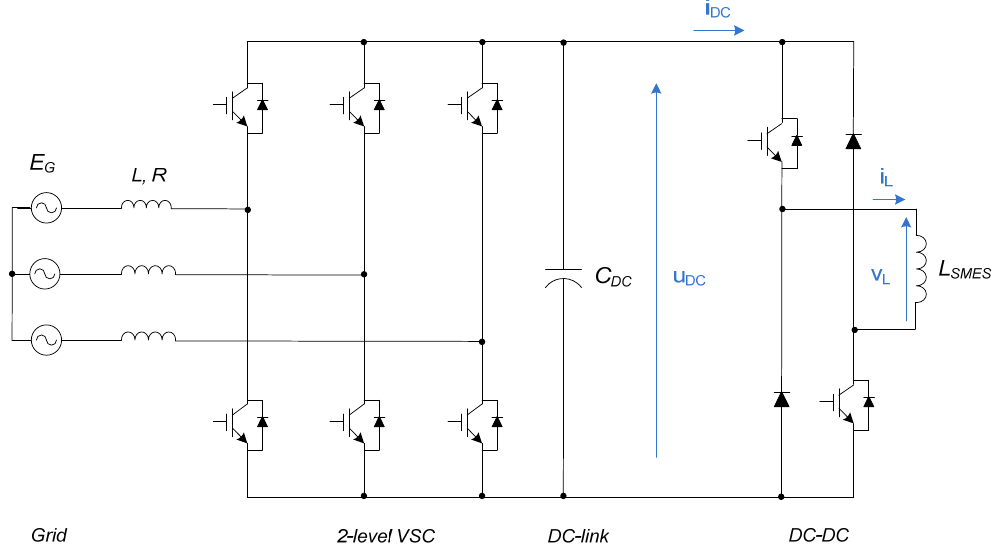
Figure 4. Power conditioning system based on a two-level